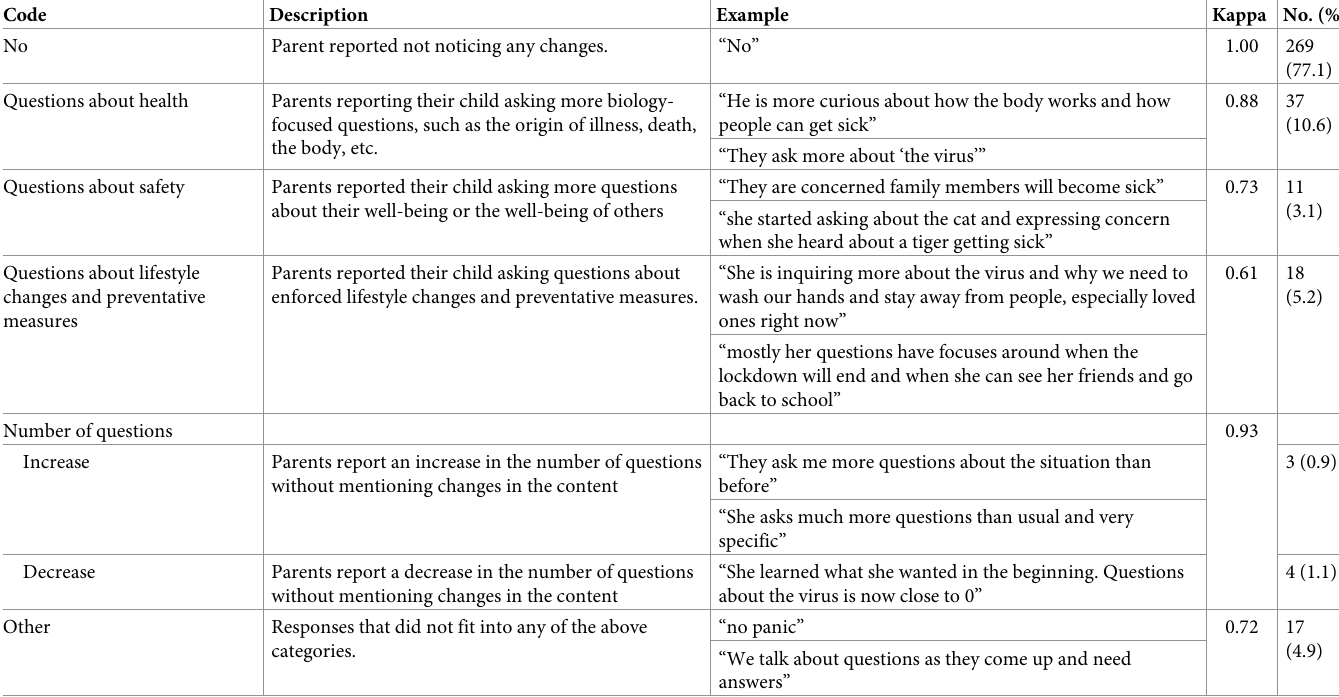
Table 3. Coding of parents’ responses about changes that they noticed in their children’s